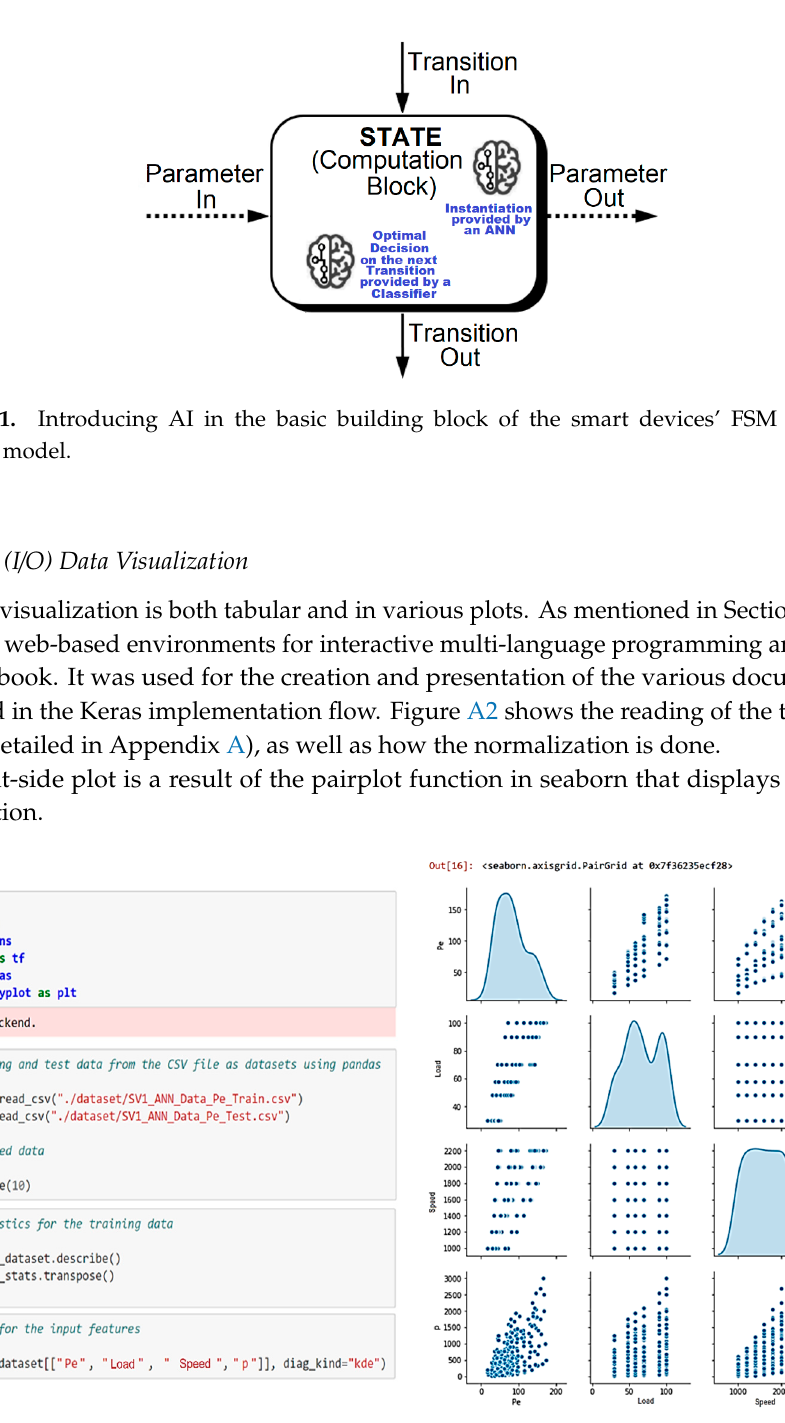
Figure A2. Training and test data—distribution of the engine-bench measurements shown in Jupyter Notebook.